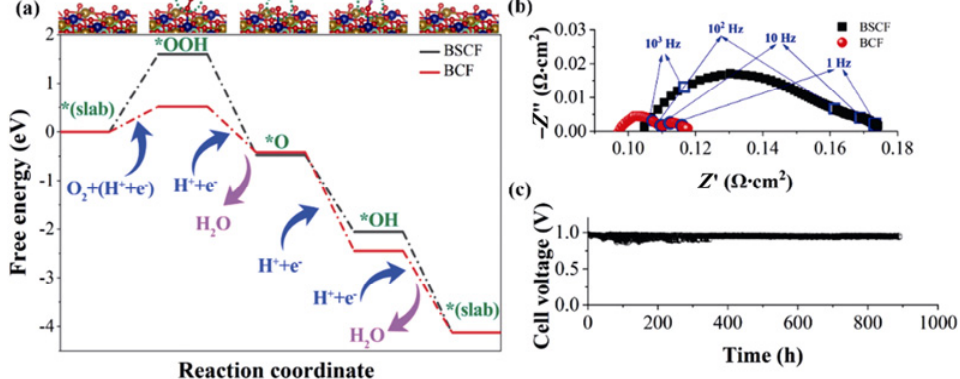
Fig. 6 (a) Free energy diagrams for the ORR at BSCF and BCF surfaces; (b) EIS plots for the cell using the BSCF and BCF cathodes tested at 700 ; (c) long ℃ -term stability test for the BCF cell under the current density of 200 mA·cm –2 at 600 .